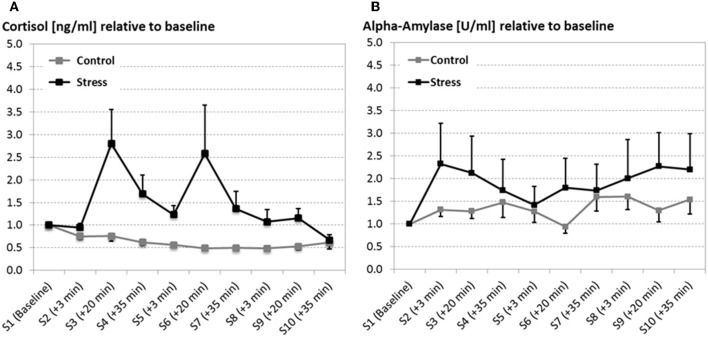
Salivary cortisol in nanogram per milliliter (ng/ml; A) and alpha-amylase in units per milliliter (U/ml; B) at several time points (S1–S10) across the experiment (error bars depict the SE of the mean). Both, cortisol and alpha-amylase are reported as relative measures, which were qualified to the baseline measurement. After the baseline measurement the SECPT/warm water control procedure was conducted three times. For all experimental sessions 20 min after the SECPT procedure (S4, S7, and S9) cortisol and alpha-amylase responses were significantly increased in stressed participants compared to the warm water control group.